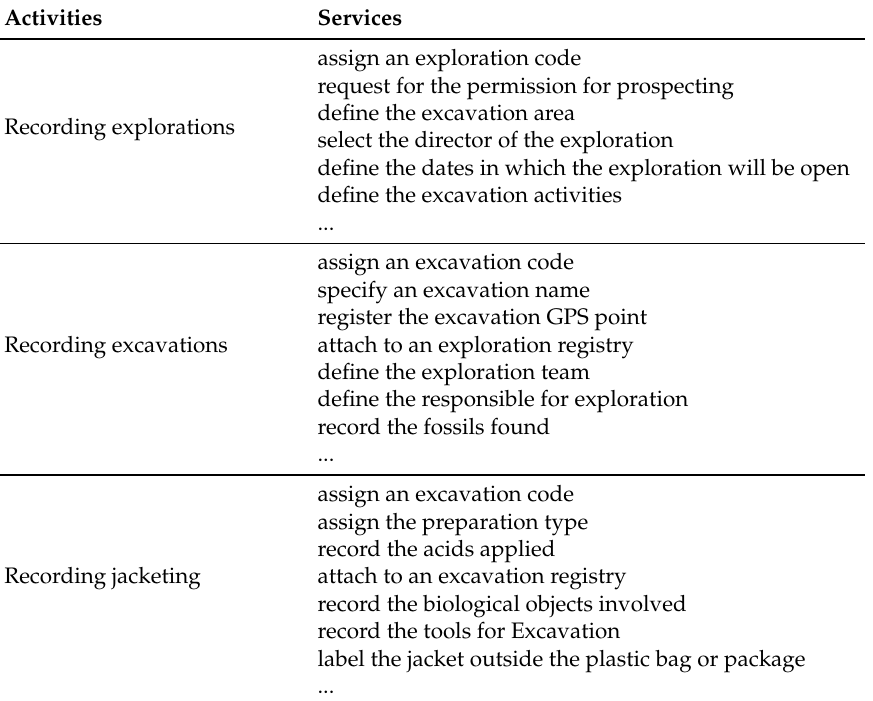
Table 2. Some of the preliminary services according to daily